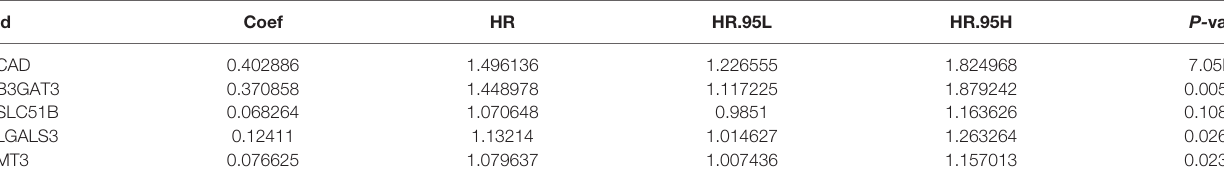
TABLE 1 | Multivariate Cox analysis results of glycosylation-related